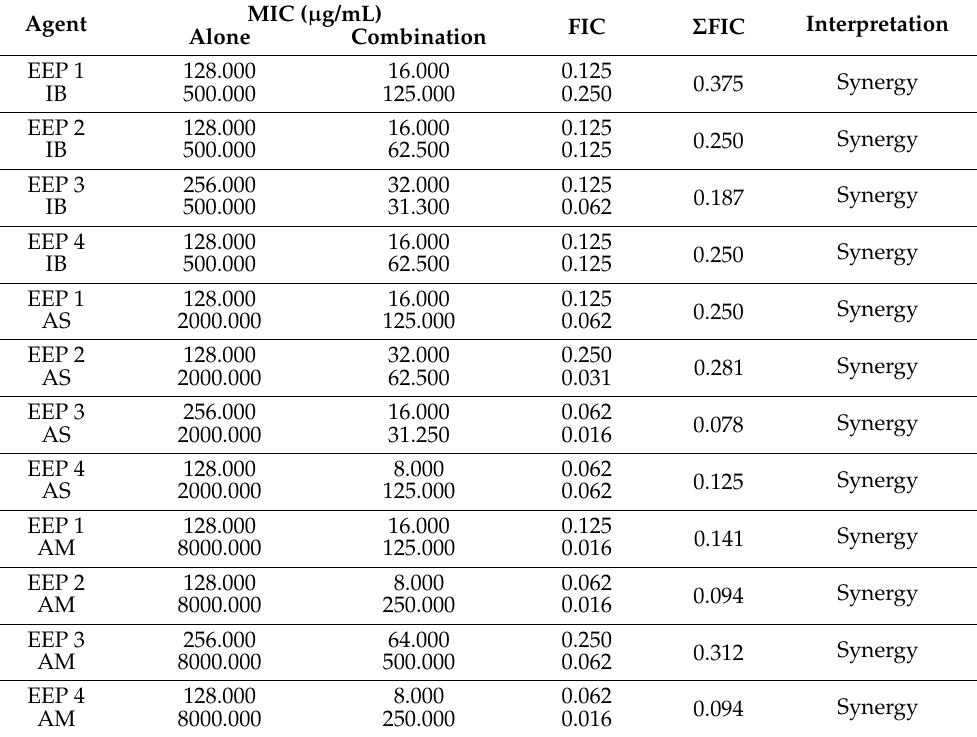
Table 4. The checkerboard analysis of drug interaction between EEPs and antipyretics (IB—ibuprofen, AS—acetylsalicylic acid, AM—acetaminophen) against S. aureus ATCC